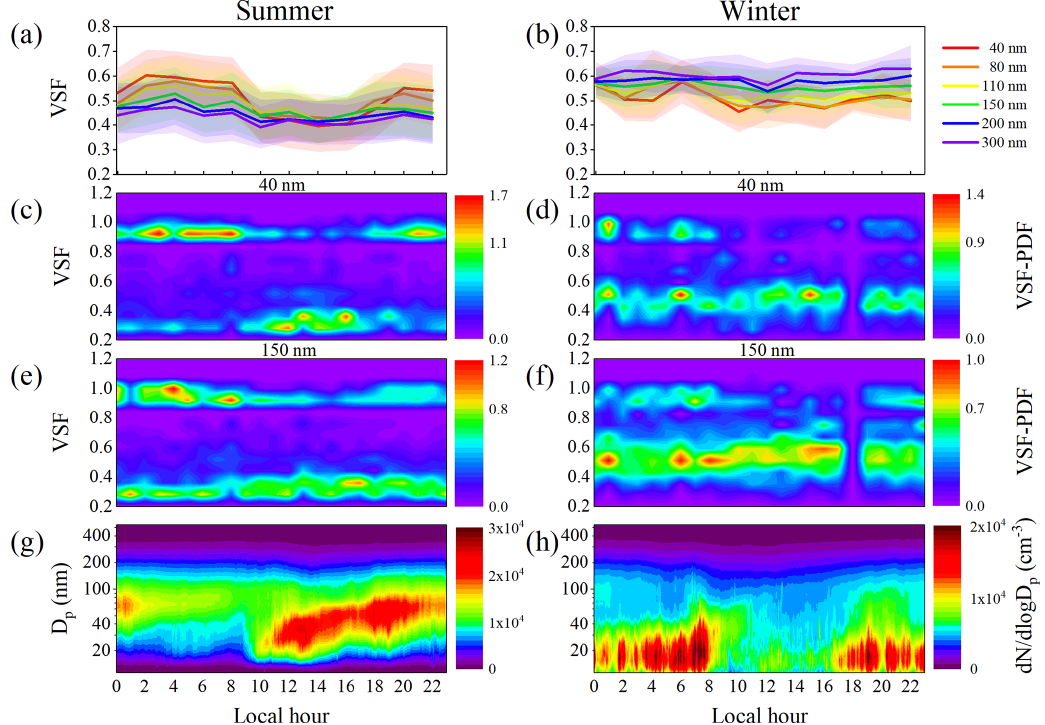
Figure 8. Diurnal variation of (a–b) mean VSF for all measured dry particle sizes, (c–f) mean VSF-PDF for 40 and 150nm particles, and (g–h) mean particle number size distribution during the summer (left) and winter (right) periods. The shaded regions in (a) – (b) denote the standard